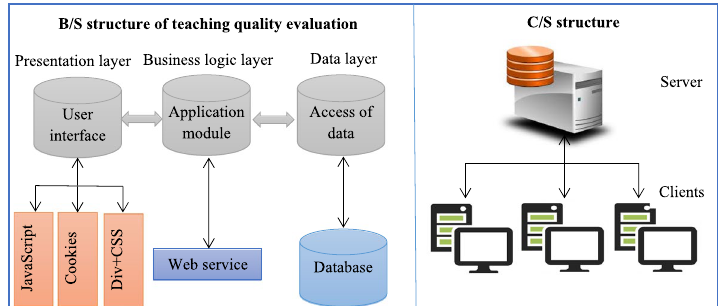
Fig. 3 Architectures of B/S and C/S for teaching quality